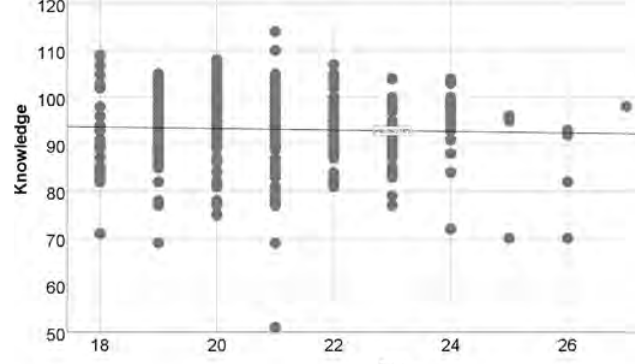
Fig 1 : Figure showing linear relationship between age and